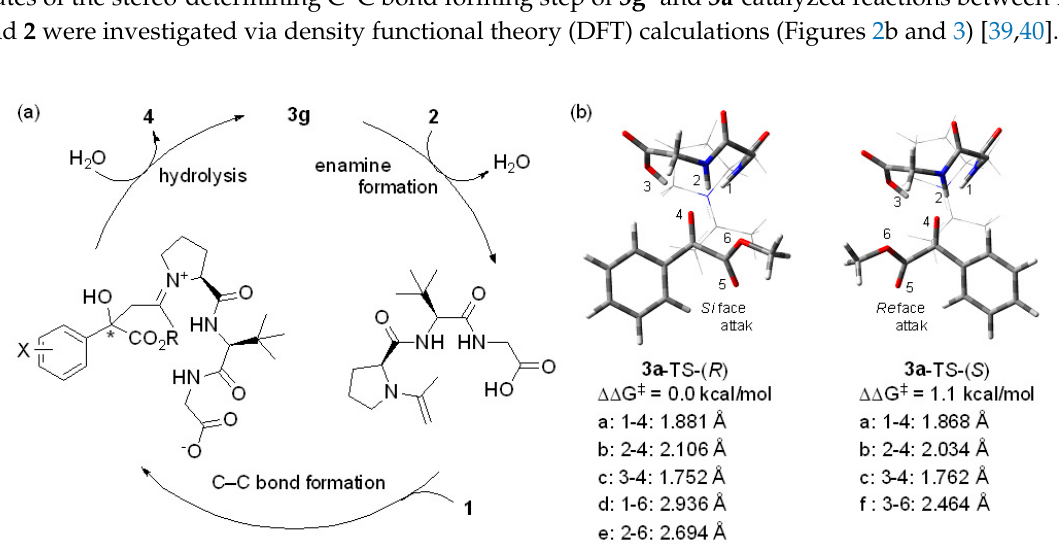
Figure 2. ( a ) A plausible catalytic cycle; ( b ) transition states of C–C bond forming step of 3a -catalyzed reaction between 1a and 2 . All calculations were carried out via CPCM(acetone)/B3LYP/6-31G(d’,p’)// B3LYP/6-31G(d’,p’) level of theory.